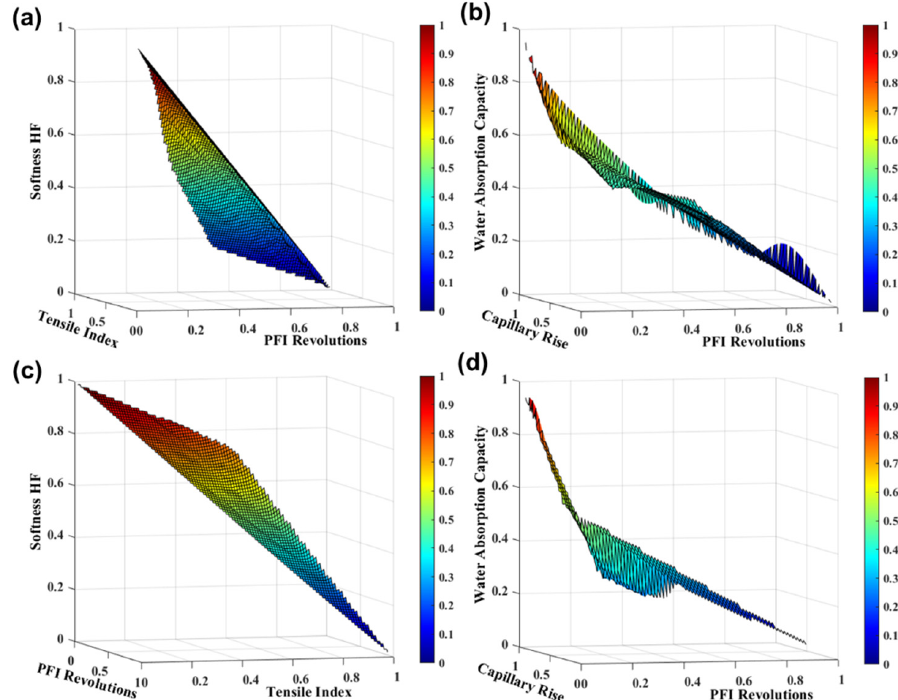
Figure 5. TSA-softness HF and tensile index properties ( a , c ) and water absorption capacity and capillary rise ( b , d ) with PFI revolutions at 3.33 N/mm ( a , b ) and 1.67 N/mm ( c , d ). The variables were normalized.